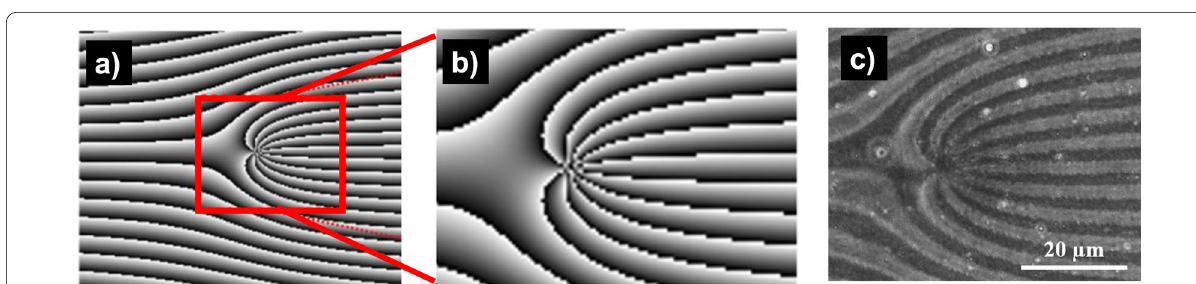
Fig. 6 a The digitally computed hologram pattern corresponding to topological charge l = − 10 , b magnified image of the region of interest from the center, c phase contrast microscopic image from the recorded sample corresponding to the region of interest